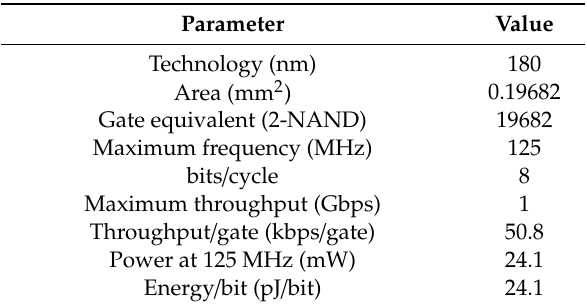
Table 1. Implementation results.